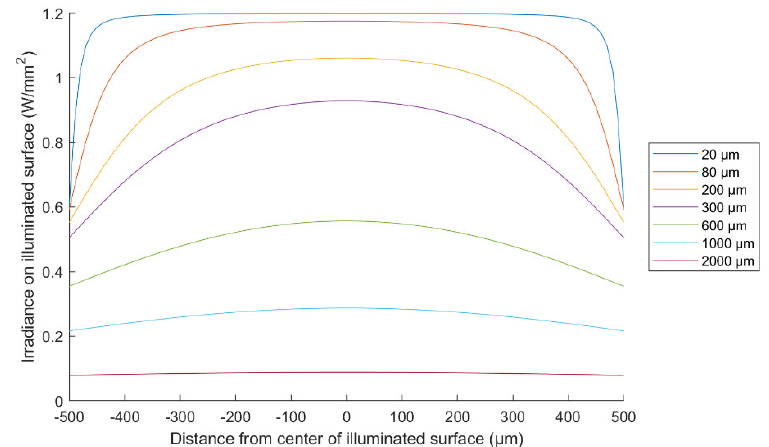
Figure 5. Square LED irradiance for several vertical distances projected on a square surface with a 1 mm 2 area.